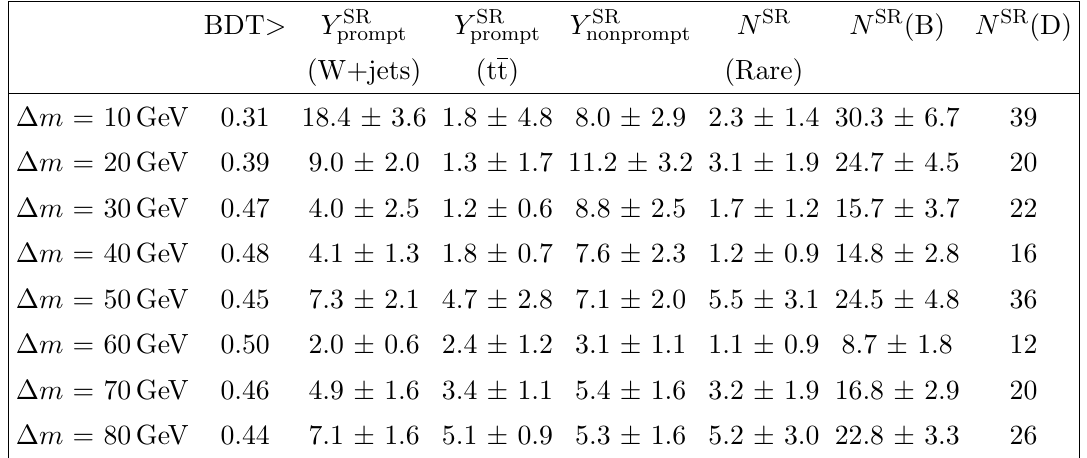
Table 5 . The MVA search: prediction of the W+jets, tt, nonprompt lepton, and other backgrounds in the eight SRs de(cid:12)ned by the threshold on the BDT output reported in the second column. The prediction of the (cid:12)rst three processes is based on data, while that of N SR (Rare), i.e. rare backgrounds, is based on simulation. The uncertainties are the quadrature sum of the statistical uncertainties, the systematic uncertainties of table 4, and for the backgrounds predicted from simulation, the cross section uncertainties. The number of total expected background ( N SR (B)) and observed data ( N SR (D)) events in each SR are also reported.